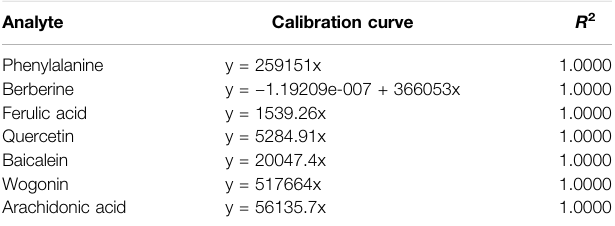
TABLE 5 | The linearities of the seven bioactive components in YDJDG determined by LC-MS/MS. Analyte